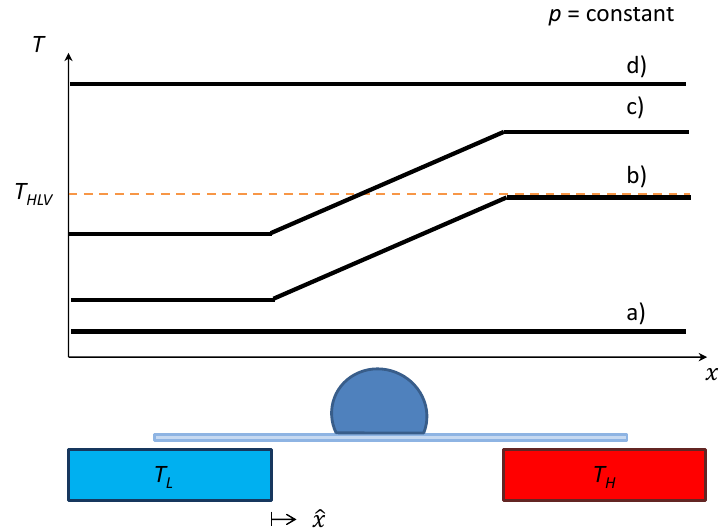
Figure 2. Temperature profiles used in this work: ( a ) Uniform surface temperature below hydrate-liquid-vapor equilibrium temperature. ( b ) Constant temperature gradient, formation. ( c ) Constant temperature gradient, dissociation. ( d ) Uniform surface temperature above hydrate-liquid-vapor equilibrium